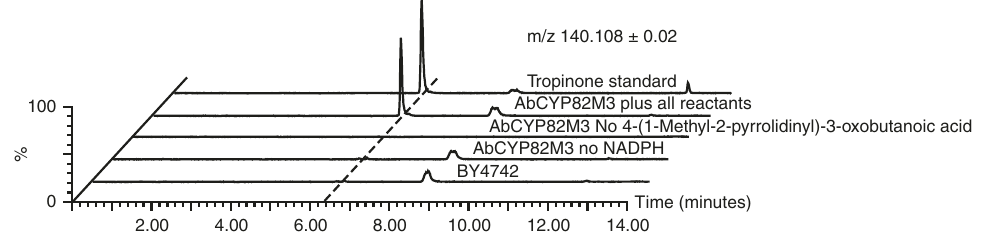
Fig. 4 AbCYP82M3 catalyzes the synthesis of tropinone from 4-(1-methyl-2-pyrrolidinyl)-3-oxobutanoic acid. Extracted ion LC/MS chromatograms in positive-ion mode ( m/z 140.108± 0.02) for the tropinone ( 7 ) [M + H] + ion from an authentic standard and a representative AbCYP82M3 enzyme reaction. AbCYP82M3 enzyme reactions lacking either NADPH or 4-(1-methyl-2-pyrrolidinyl)-3-oxobutanoic acid ( 5 ) as well as those performed